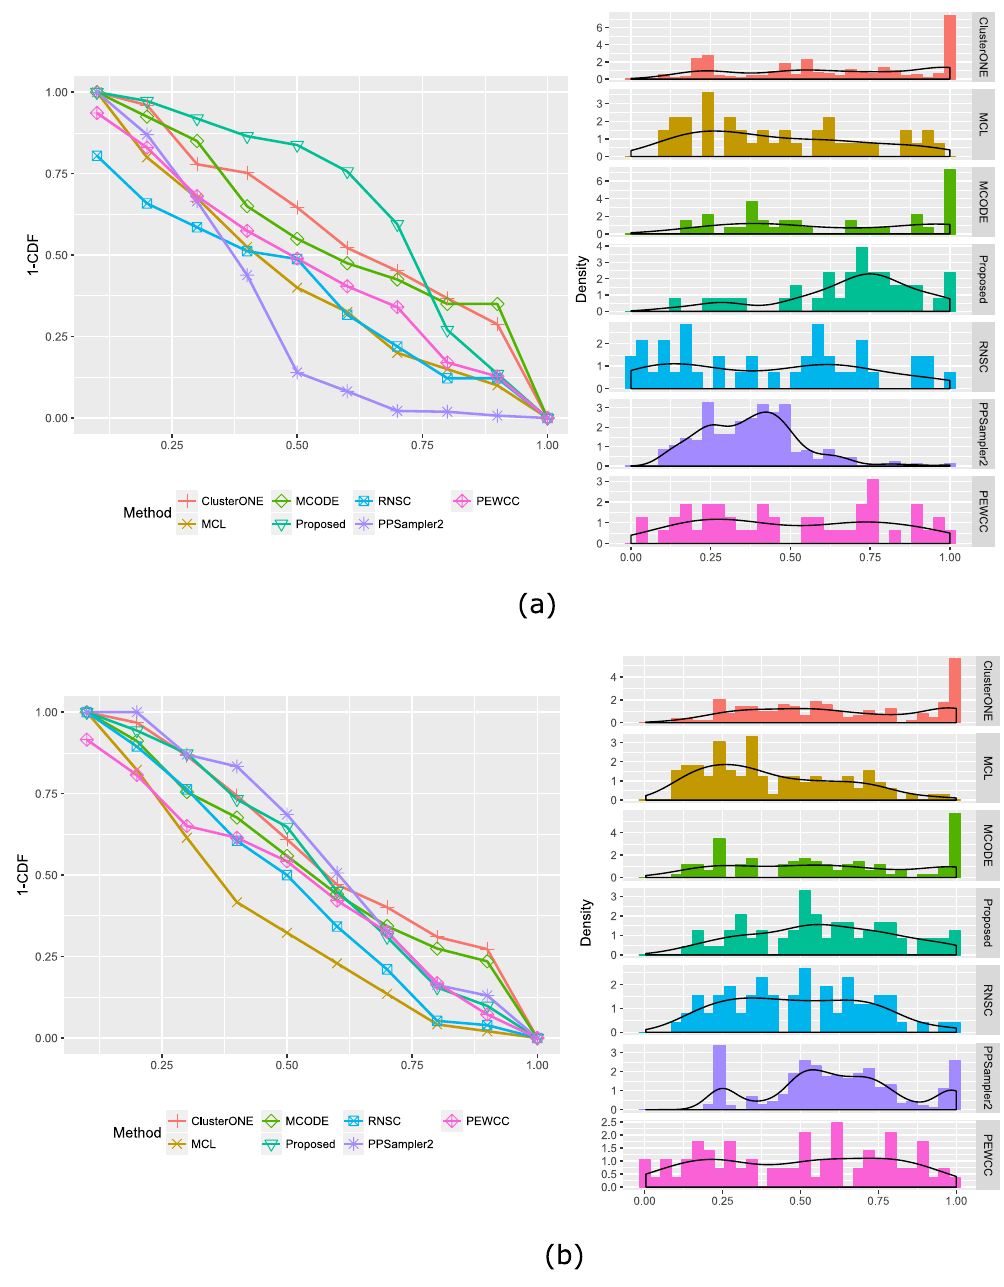
Figure 7. Distribution of functional similarity scores - the left pane show the fraction of identified modules having similarity score above certain value x , while the right pane show the distribution of similarity score. ( a ) Shows the results on Gavin data set and ( b ) shows the results on Krogan_Extended